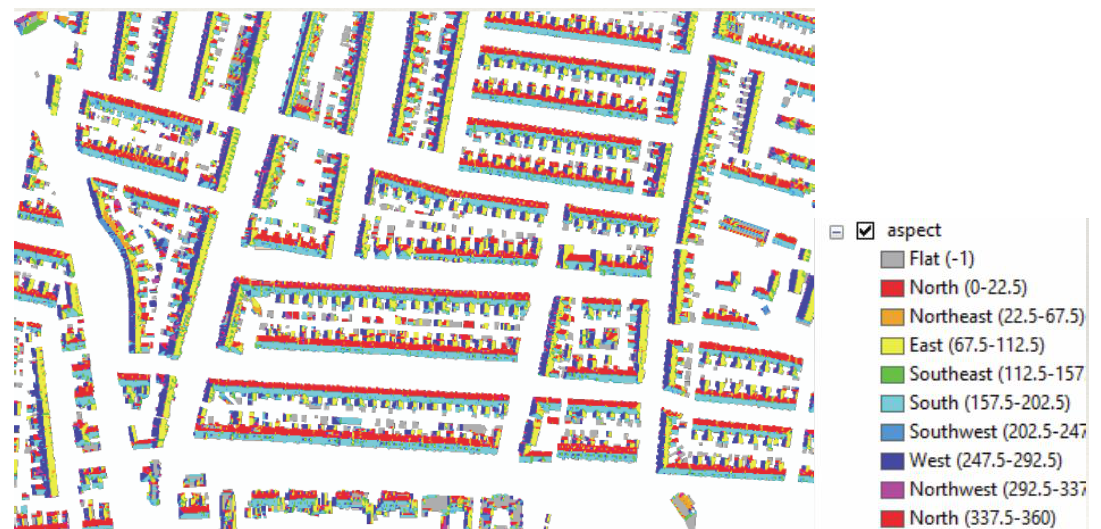
Figure 6. VNG 3D model in GIS platform: ( a ) Terrain model, ( b ) VNG in shape file format, ( c ) Querying in VNG, ( d ) Skyline analysis, ( e ) Sun-shadow volume, ( f ) Analysing roof types (flat etc.) and roof